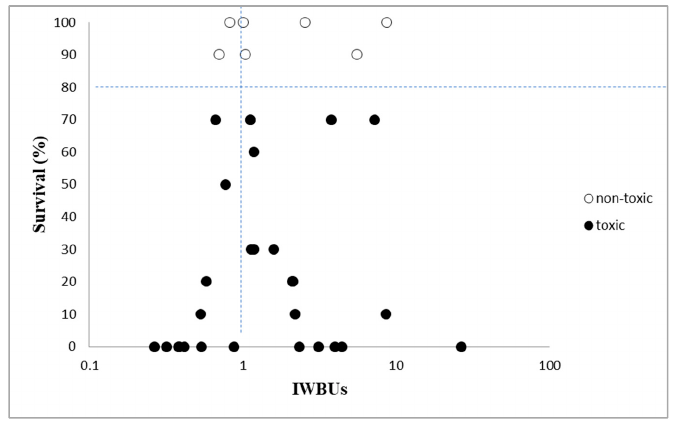
Figure 7. Diagram of interstitial water benchmark units and the Hyalella azteca survival rate correlation. Appl. Sci. 2021 , 11 , x FOR PEER REVIEW